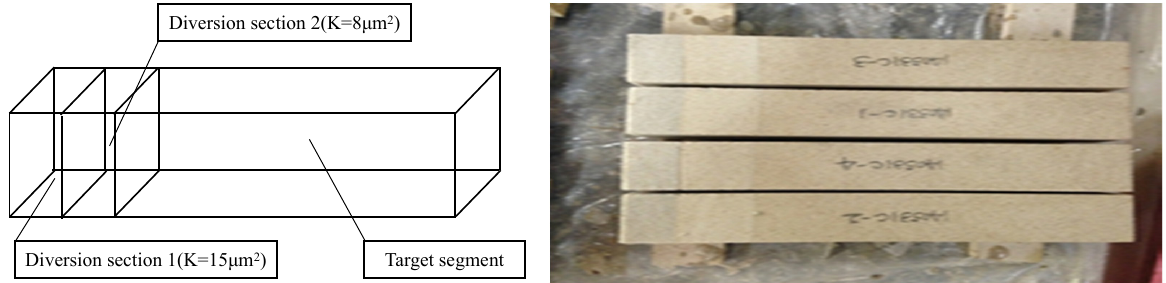
Figure 1. Three-section core with diversion section.